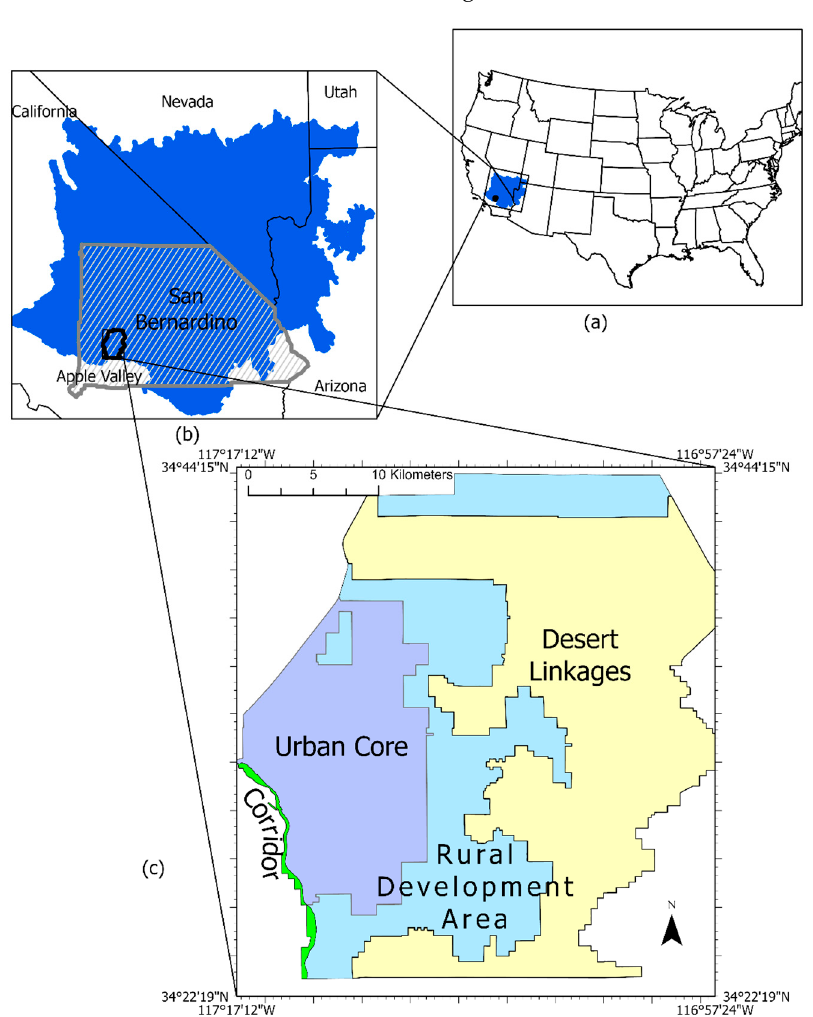
Figure 1. Location of the Apple Valley Multi-Species Habitat Conservation Plan Area in context with ( a ) the United States and the Mojave Desert Ecoregion (blue), ( b ) San Bernardino County, and ( c ) Plan area with the Development Zone (Rural Development Area (light blue) including the Urban Core (purple)), Desert Linkages Zone (yellow), and Mojave River Corridor (green). Table 2. Proposed covered species for the Apple Valley Multi-Species Habitat Conservation Plan.